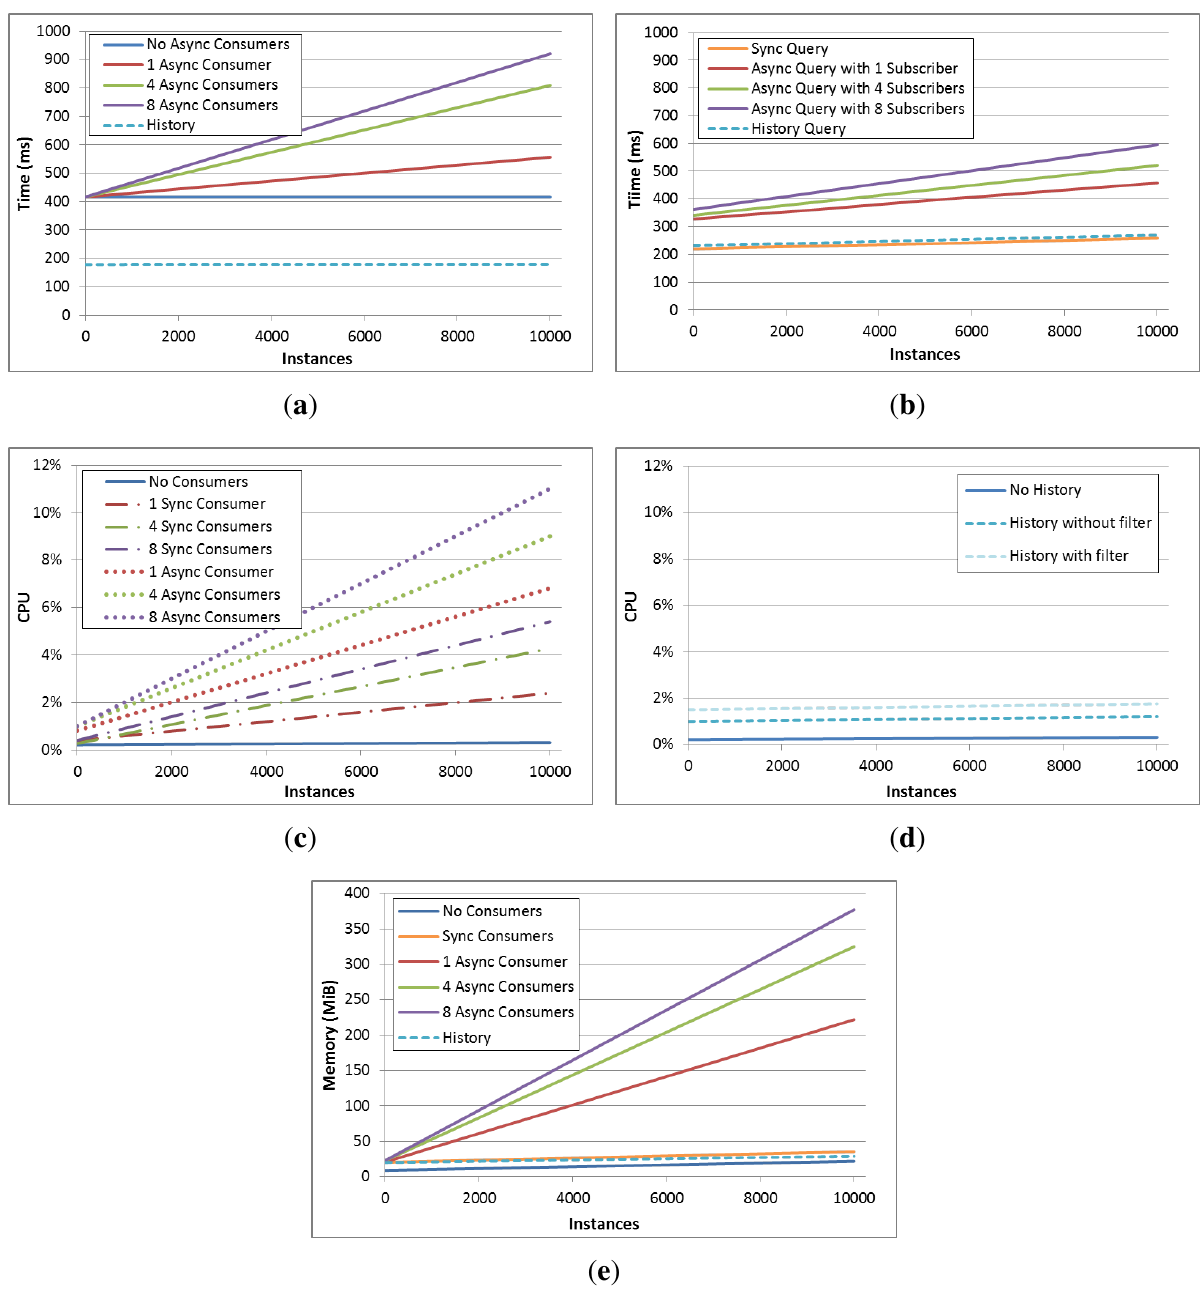
Figure 5. System performance in the different testing scenarios. ( a ) Instance adding times; ( b ) Synchronous, asynchronous and history query times; ( c ) CPU usage with different consumer count; ( d ) CPU usage with different history configurations; ( e ) Memory usage in the different